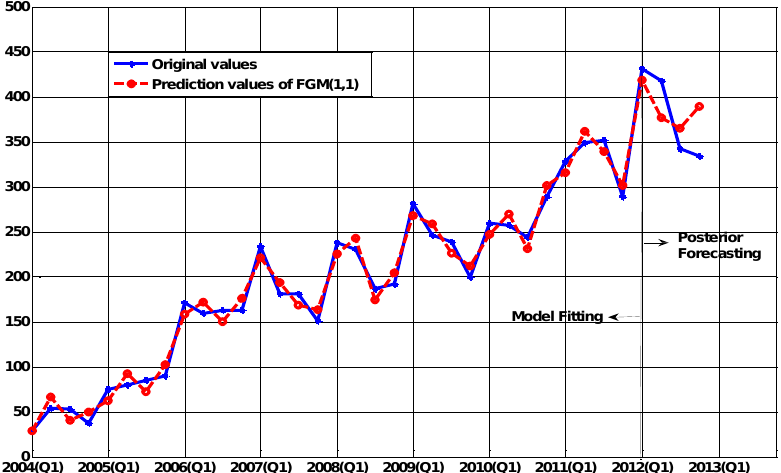
Figure 3. The comparison between the real values and the simulation values of the FGM(1,1) model.